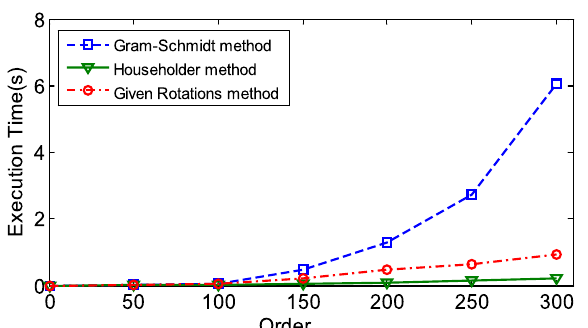
Fig. 5 Average execution time using Tchebichef moments with re-orthonormalization methods (Gram– Schmidt, Householder, and Given